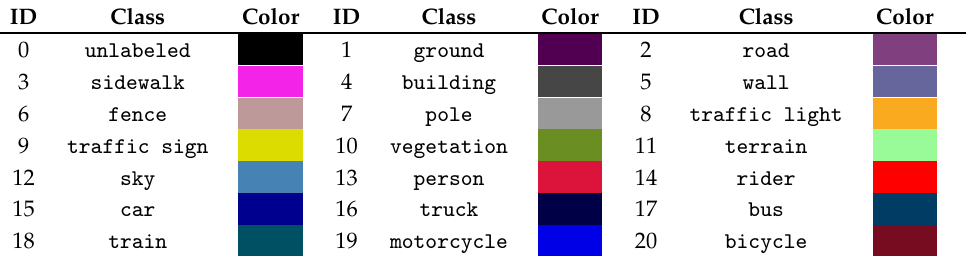
Figure 3. Sample images of Cityscapes: source images ( upper ) and GT images ( lower ). Table 1. Semantic labels and corresponding